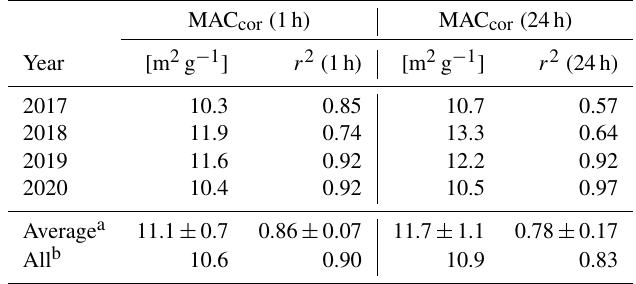
Table 9. Year-to-year variability of MAC cor (PSAP–CLAP; λ = 550nm) and r 2 at Barrow.